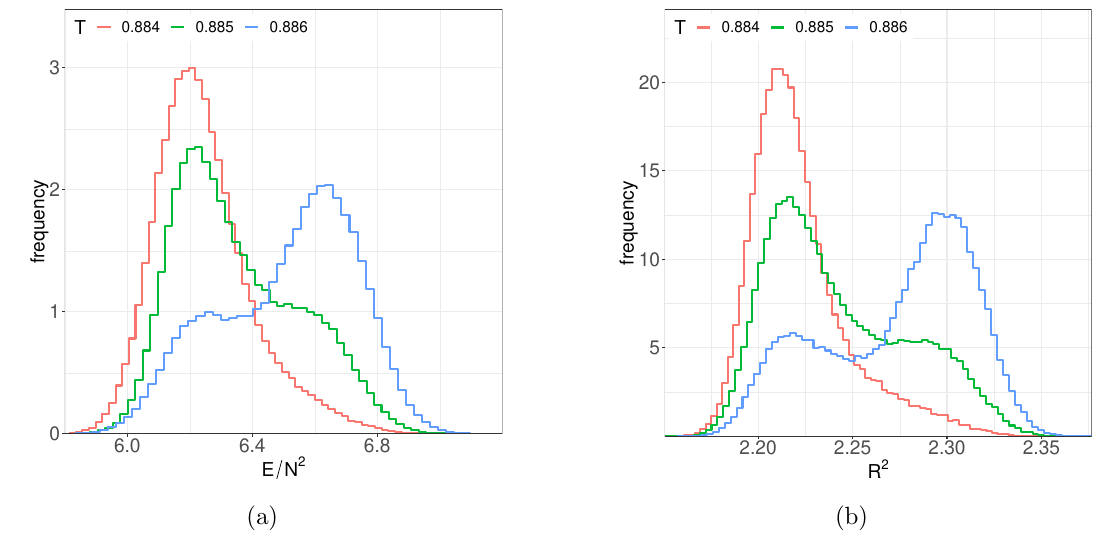
Figure 11. N = 48, L = 24, D = 10: a) binned E for various T . b) binned R 2 for various T .